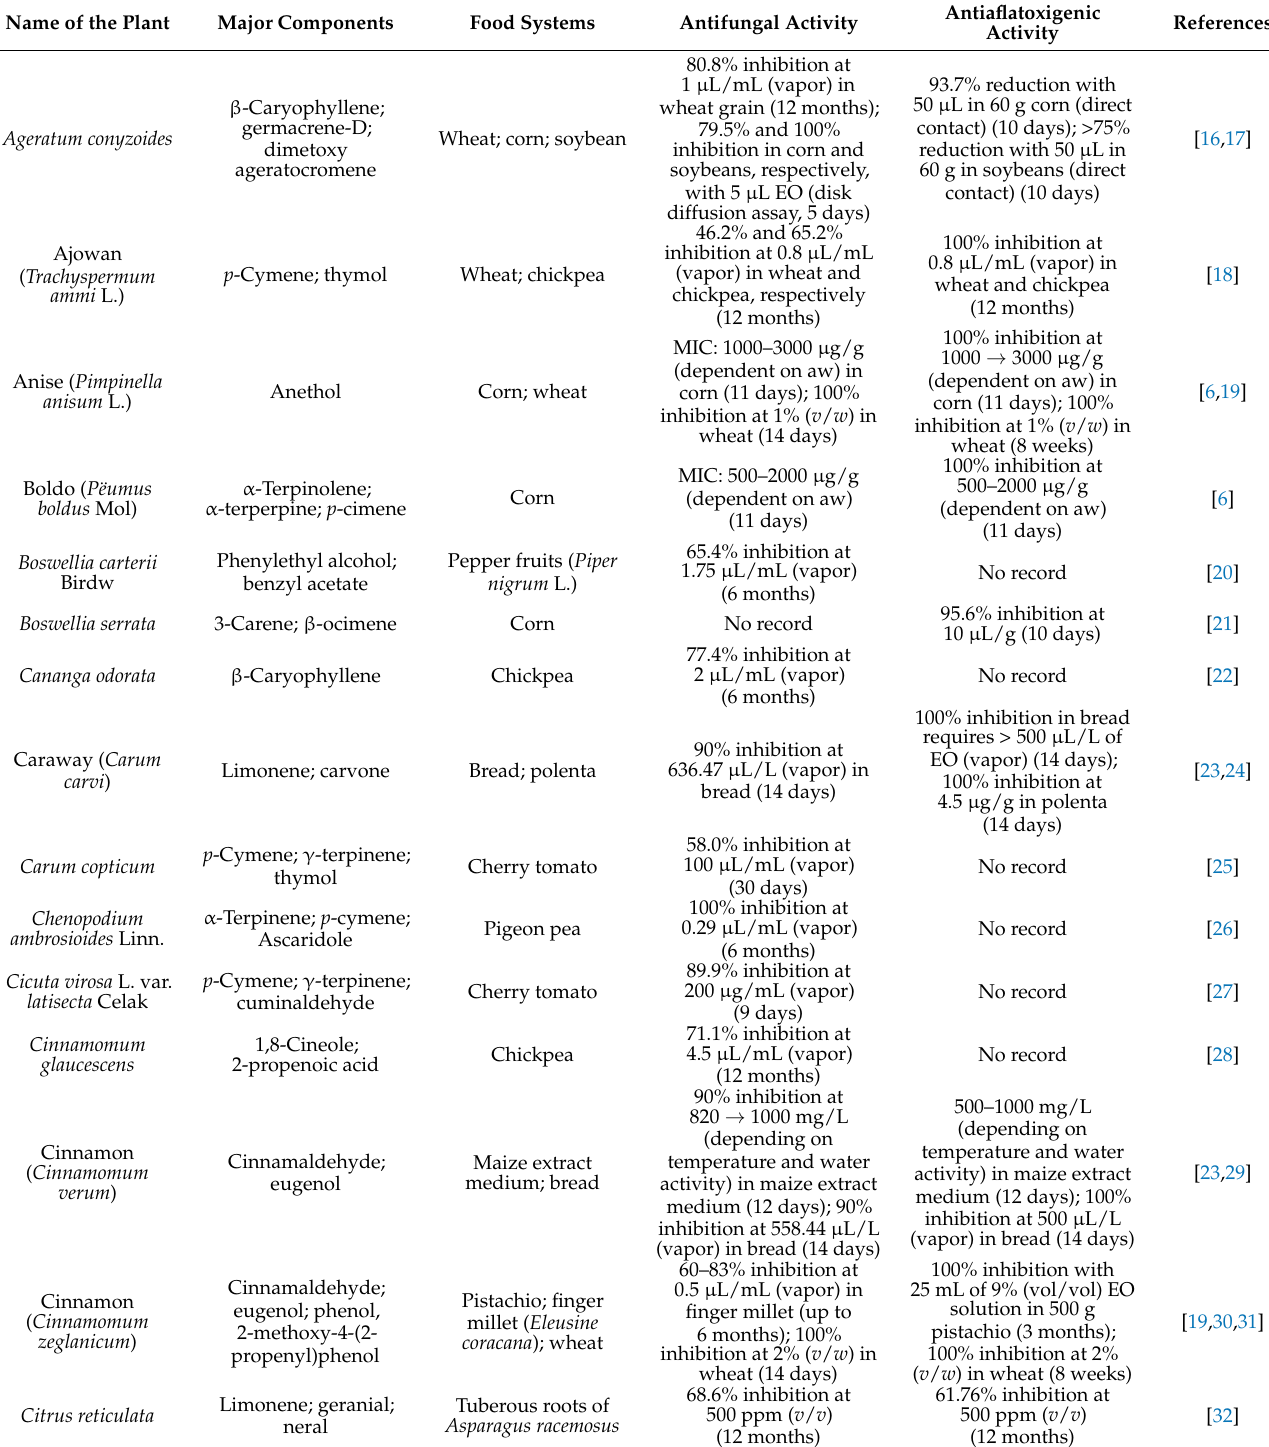
Table 1. In situ antifungal and antiaflatoxigenic activities of plant-derived natural compounds against A. flavus in different food